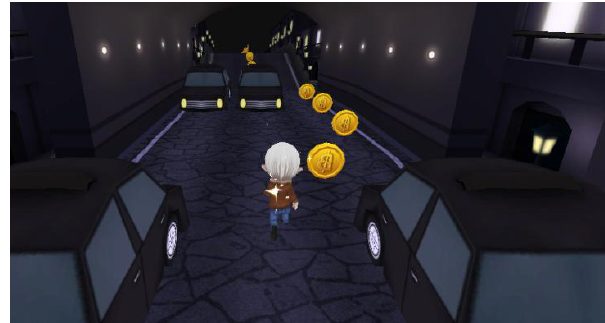
Figure 15. Integrating Kinect Server and